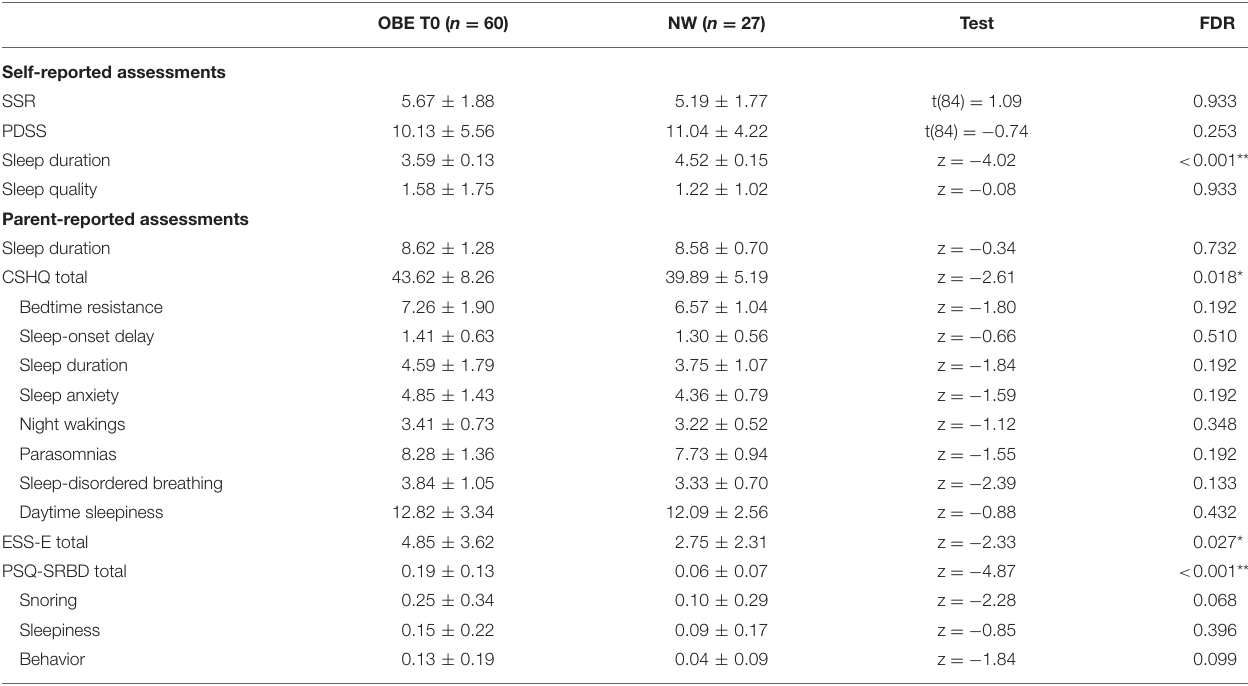
TABLE 3 | Sleep results comparison between OBE and NW.